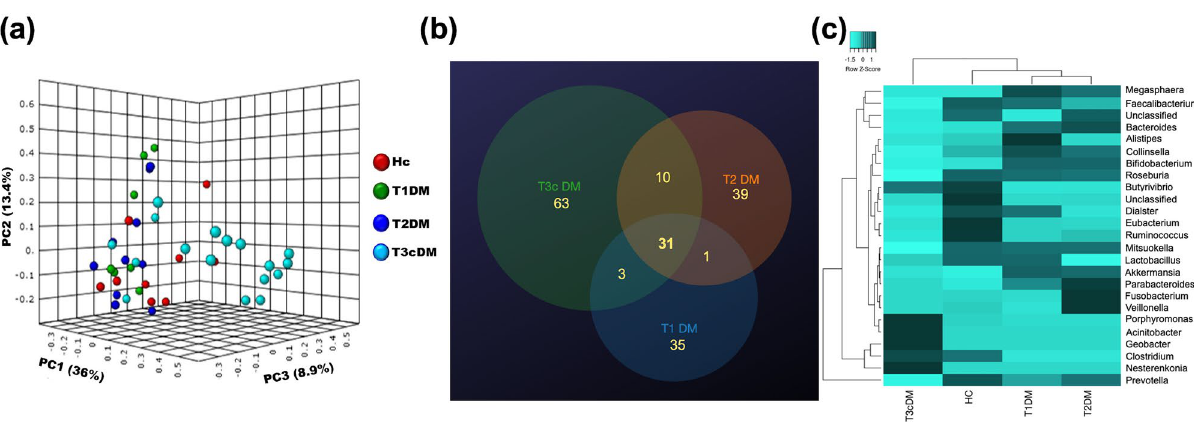
Figure 5. Bacterial characteristics at the genus level taxa. ( a ) PCoA plot, based on Bray Curtis distance matrix, showing significantly different clustering of Type 3c diabetes (Light blue dots) compared to the other groups (Red dots- healthy control, Green dots- Type 1 diabetes, Deep blue dots- Type 2 diabetes). ( b ) Venn diagram showing the numbers of unique and common genera between the three diabetes groups. ( c ) Heatmap with clustering dendrograms depicting the group wise difference in abundance of the organisms at the genus level taxa. The colour intensity representing the median relative abundances is based on the row z